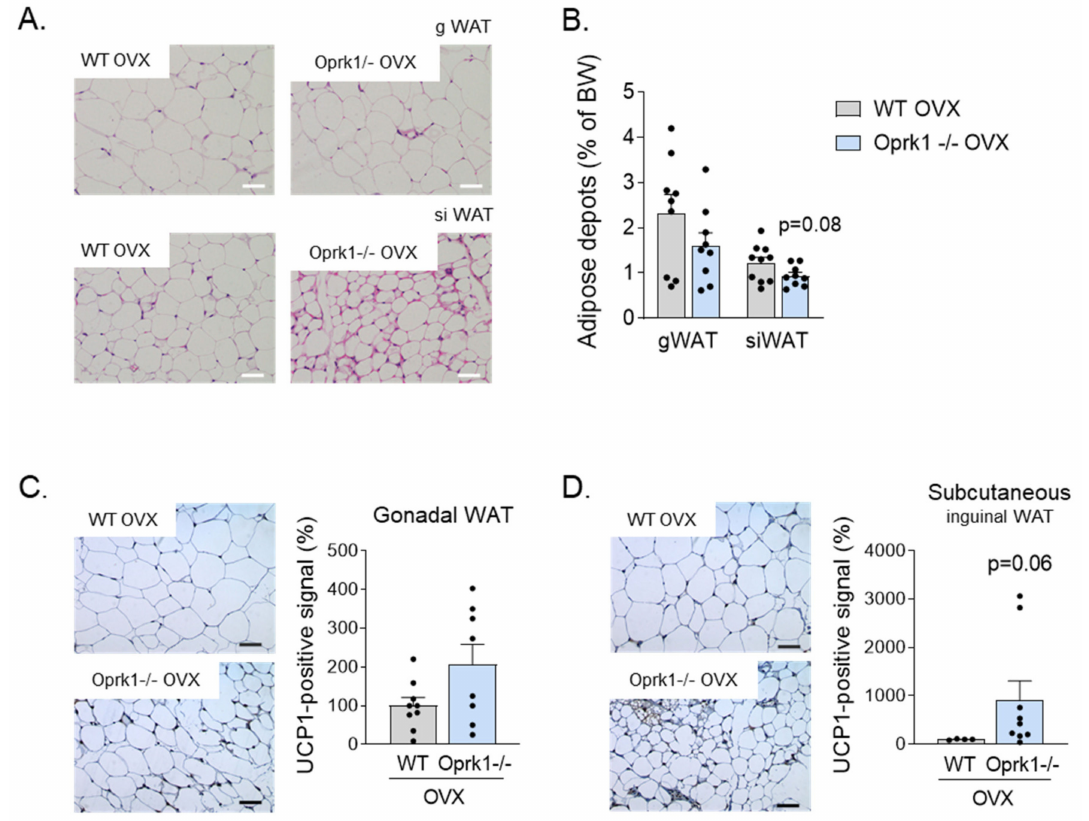
Figure 4. WAT browning in the E2 withdrawal model. ( A ) Representative images of Hematoxylin and Eosin staining of gonadal WAT (gWAT) and subcutaneous inguinal WAT (siWAT) from WT and Oprk1 − / − mice under OVX conditions. Scale bar: 50 µ m. ( B ) Gonadal and subcutaneous inguinal fat depots expressed as percentage of BW in ovariectomized WT and Oprk1 − / − mice. ( C , D ) Rep- resentative images and quantification of UCP1 immunostaining in gWAT (C) and subcutaneous inguinal WAT (siWAT) from same animals. Values are expressed as mean ± SEM (n = 6–12 per group). Mann–Whitney (non-parametric conditions) was used to compare the two groups (OVX-WT and OVX-Oprk1 − / −